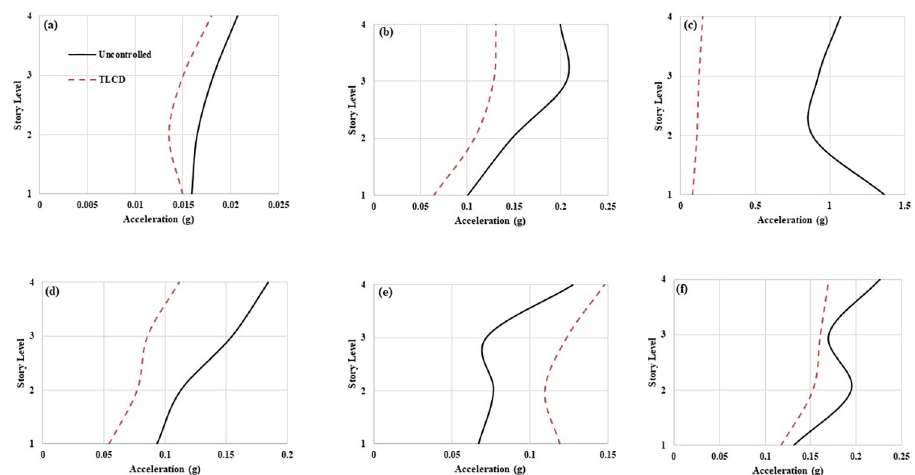
Fig 8. Peak acceleration responses of MDOF structure equipped with and without TLCD at (a) 0.65 Hz, (b) 1.17 Hz, (c) 1.3 Hz, (d) 1.43 Hz, (e) 1.95 Hz, and (f) Seismic